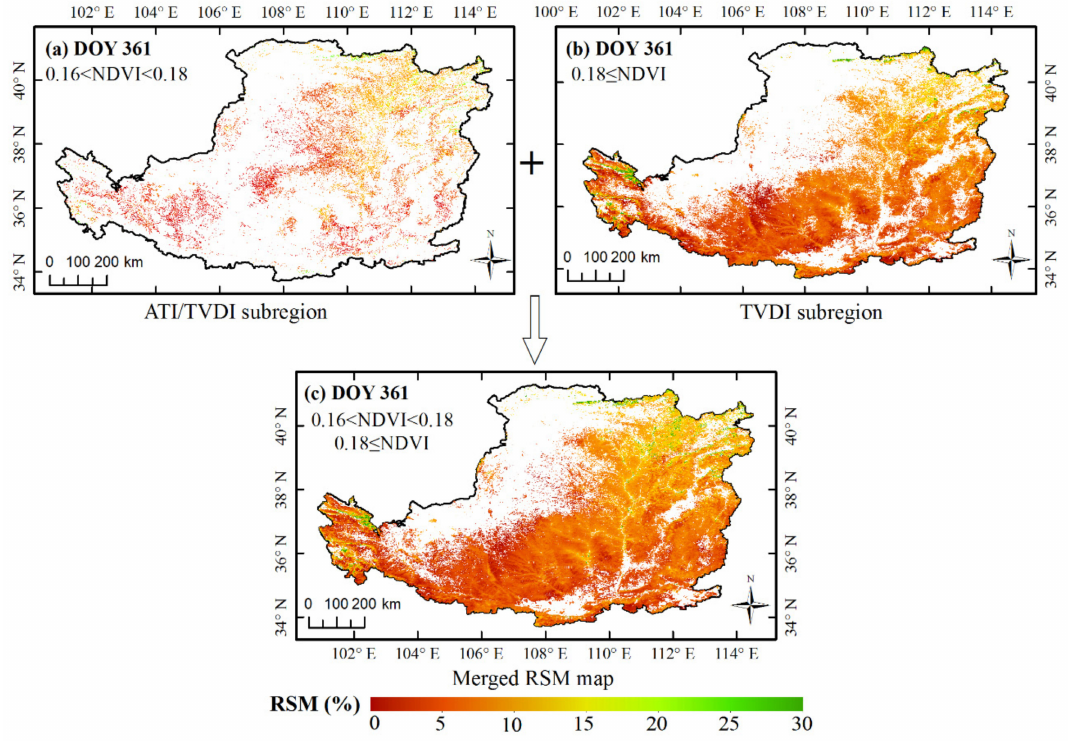
Figure 8. The RSM map was produced by merging the RSM of two subregions on DOY 361. ( a ) The RSM map of ATI / TVDI subregion, ( b ) the RSM map of TVDI subregion, ( c ) the merged RSM map of the